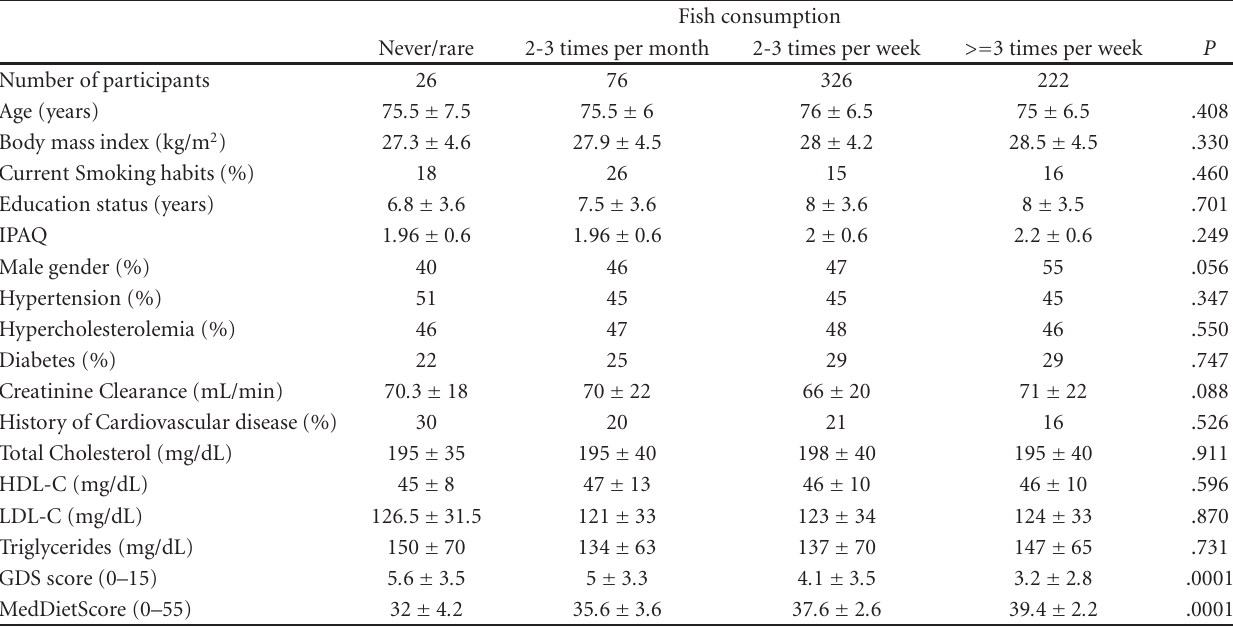
Table 2: Demographic, behavioral, and clinical characteristics, by fish consumption